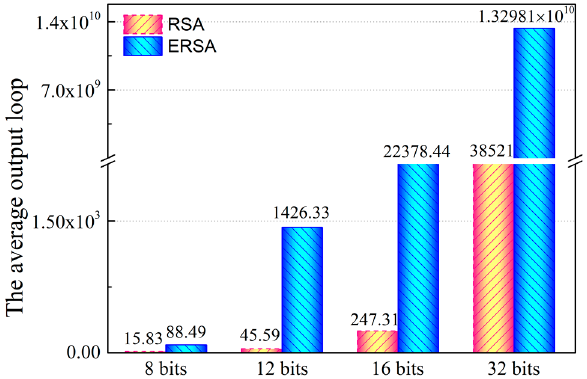
Figure 3. The average output loop 𝑖 of Pollard’s rho method.